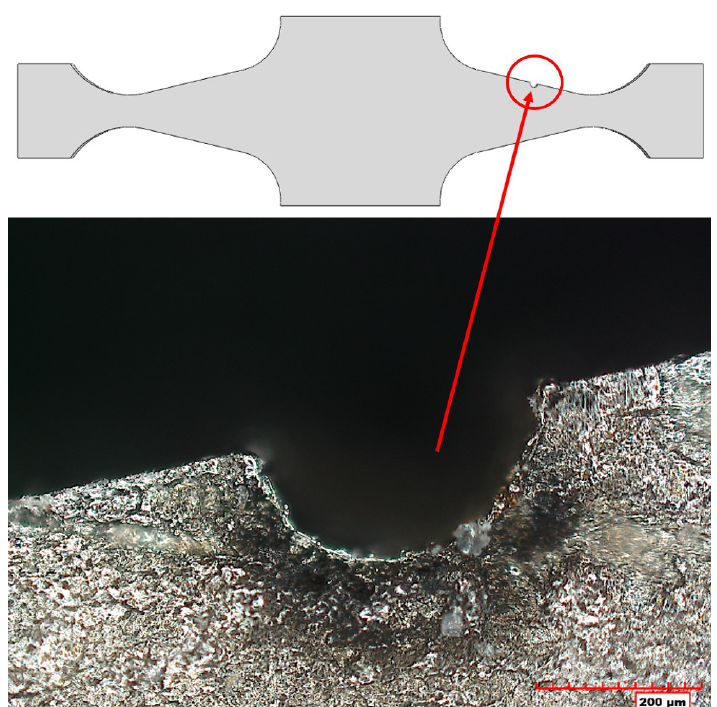
Figure 15. Notched rough finished wrought specimens prepared with a W-EDM wire radius of 0.125 mm. The average radius of the notch measured was 0.180 mm.